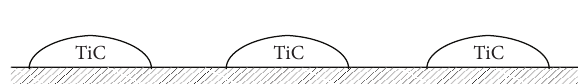
Figure 6: Structure of the samples after chemical deposition (CVD) of titanium carbide at sequential supplying of titanium tetrachloride and methane